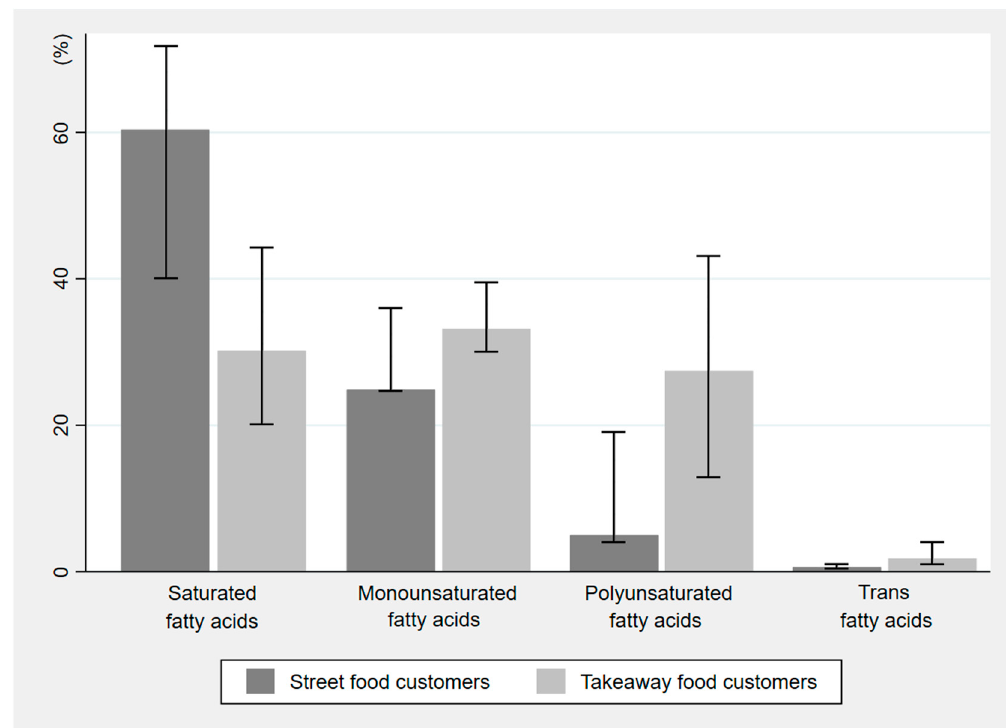
Figure 2. Estimated fatty-acid contents (g/100 g of total fat) of the purchases made by a sub-sample ( n = 474) of street food and takeaway food customers observed in Sarajevo and Banja Luka, Bosnia and Herzegovina. The values shown are presented as median and inter-quartile range.